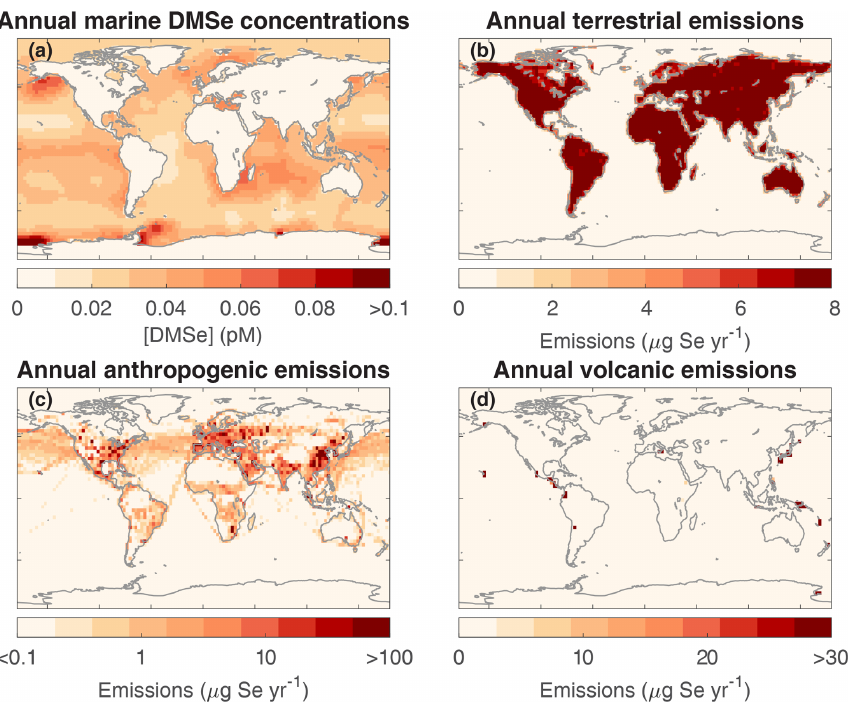
Figure 3. Spatial distribution of Se sources. Each source map is normalized so that 1GgSeyr − 1 would be emitted globally. This is scaled during the sensitivity